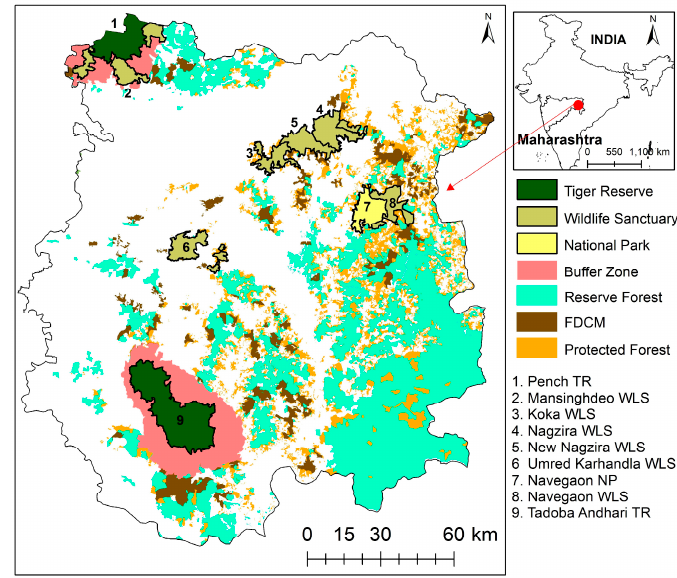
Figure 1. Study area map depicting the distribution of protected areas and forest outside protected area.